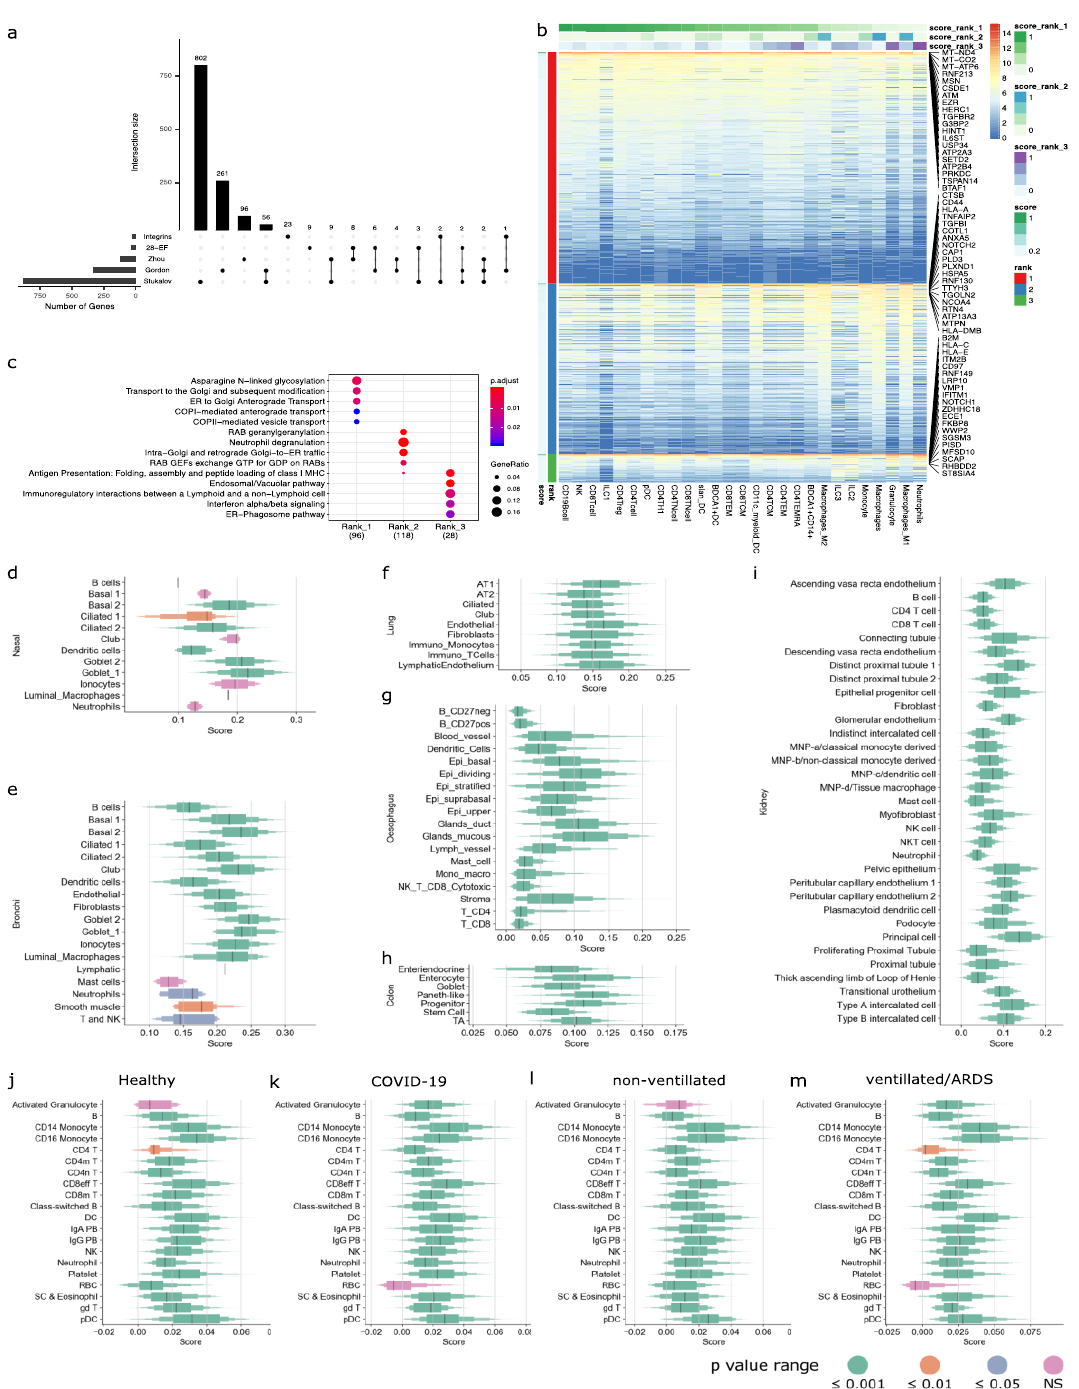
Figure 5. Enrichment of human lung cell line-derived virus–host interactome in circulating and tissue immune cells. ( a ) Intersection plot of different gene lists, shows size of the gene lists in bottom left panel, and overlapping size in the top panel. Overlapping genes between the gene lists are represented by vertical lines. ( b ) DIME heatmap showing ranked enrichment of Stukalov gene list in the circulating immune cells. The ranks depict the clusters as identified by DIME (see methods). Top 20 genes for each rank are shown. The cells are ordered based on the score of the rank 1 (top-weighted rank). Expression values are in log2(cpm + 1). ( c ) Pathway analysis (using Reactome) of the top 25 percent of genes of each rank, as identified by DIME. Boxplot showing the distribution of gene score of Stukalov genes for different cell types in the different tissue datasets of ( d ) nasal, ( e ) bronchi, ( f ) lung, ( g ) esophagus, ( h ) colon, and ( i ) kidney. Boxplot showing distribution of gene score of Stukalov genes in the PBMC dataset of ( j ) healthy controls, ( k ) all COVID-19 patients, ( l ) non- ventilated COVID-19 patients, and ( m ) COVID-19 patients that developed ARDS and were on ventilator. Black line rep- resents median; height of box corresponds to number of cells in score range. Color of the box corresponds to the Wilcoxon p value computed with the alternative set to > 0. See bottom right of Figure 2 for p value range.